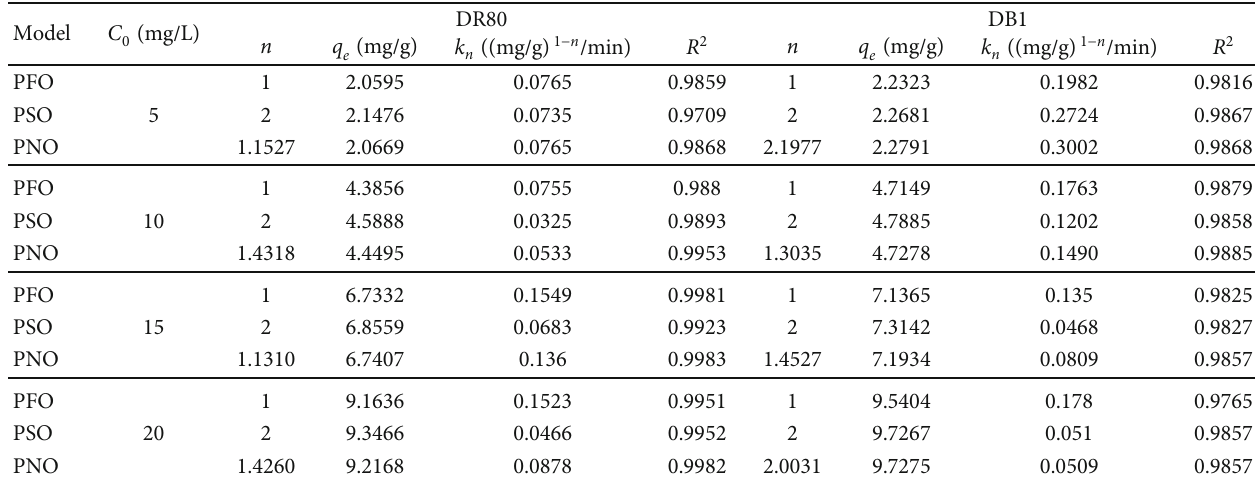
Table 2: Kinetic parameters and coe ffi cients of determination of the PFO, PSO, and PNO models for the adsorption of DR80 and DB1 by Pec-Ca for initial dye concentrations C 0 of 5, 10, 15, and 20